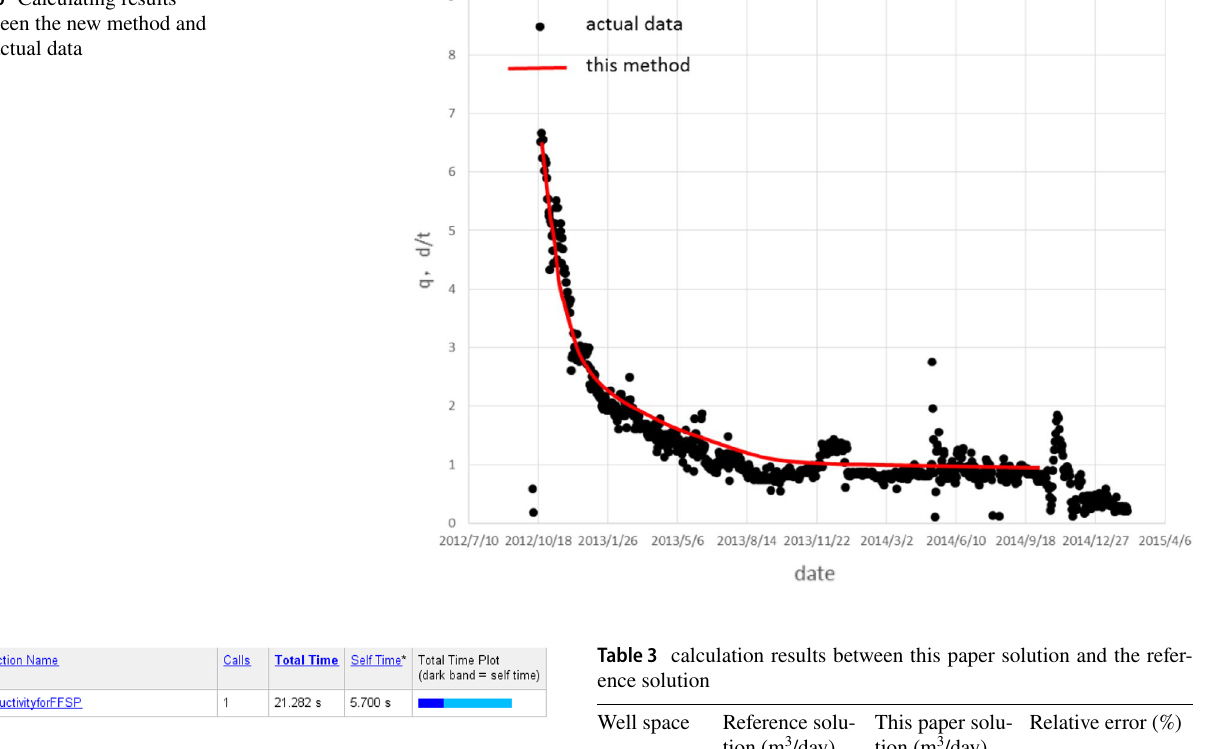
Fig. 7 Running time of productivity prediction program